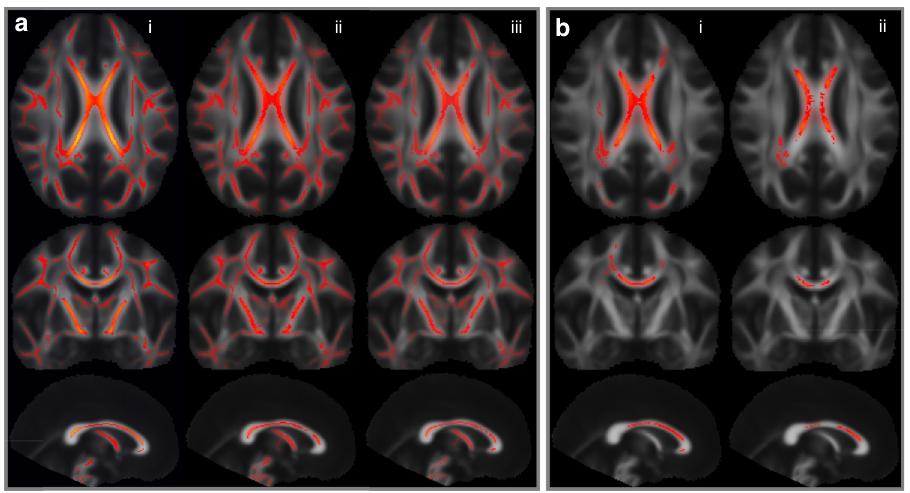
Fig. 3 Diffusion (TBSS) data mapping from MAP1B LoF carriers compared with controls. Rows one, two, and three show, respectively, axial, coronal, and sagittal aspects of brain (MNI coordinates: 1, − 13, 19) where heat map (red/yellow) intensity represents a signi fi cant change in fractional anisotropy (FA). a We compared MAP1B LoF carriers ( n = 9) with three control groups (column i: normal range controls ( n = 181), column ii: controls with small CC volume ( β < − 1.5 SD, n = 15), and column iii: controls with small WM volume ( β < − 1.5 SD, n = 10)) and found the carriers to have signi fi cantly lower brain-wide FA compared with all three control groups. b To determine whether a smaller CC volume generally leads to a decrease in FA, we compared the, column (i) 15 controls with smaller CC with 166 normal range controls and, column (ii) the ten controls with smaller WM with 160 normal range controls and found a reduction in FA only in the densest part of the CC. Family wise error (FWE) corrected signi fi cance threshold of